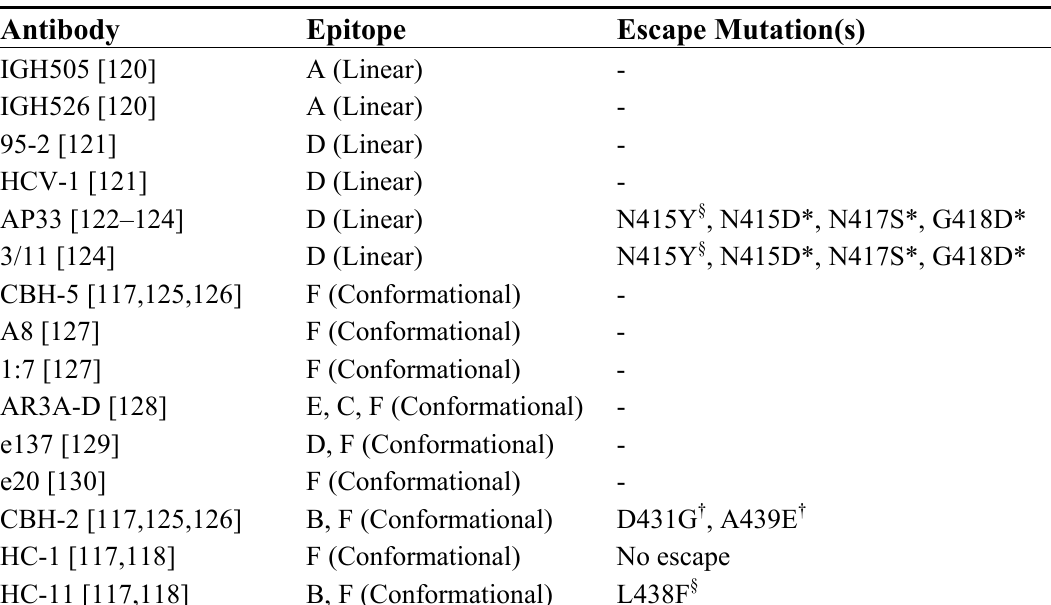
Table 1. Broadly neutralizing anti-E1 and -E2 antibodies. Letters A to F indicate the antibody epitopes shown in Figure 2. Symbols indicate the effect of each escape mutation on virus fitness: §, Impaired viral spread; *, Increased sensitivity to nAbs; † , Wild-type phenotype; -, not